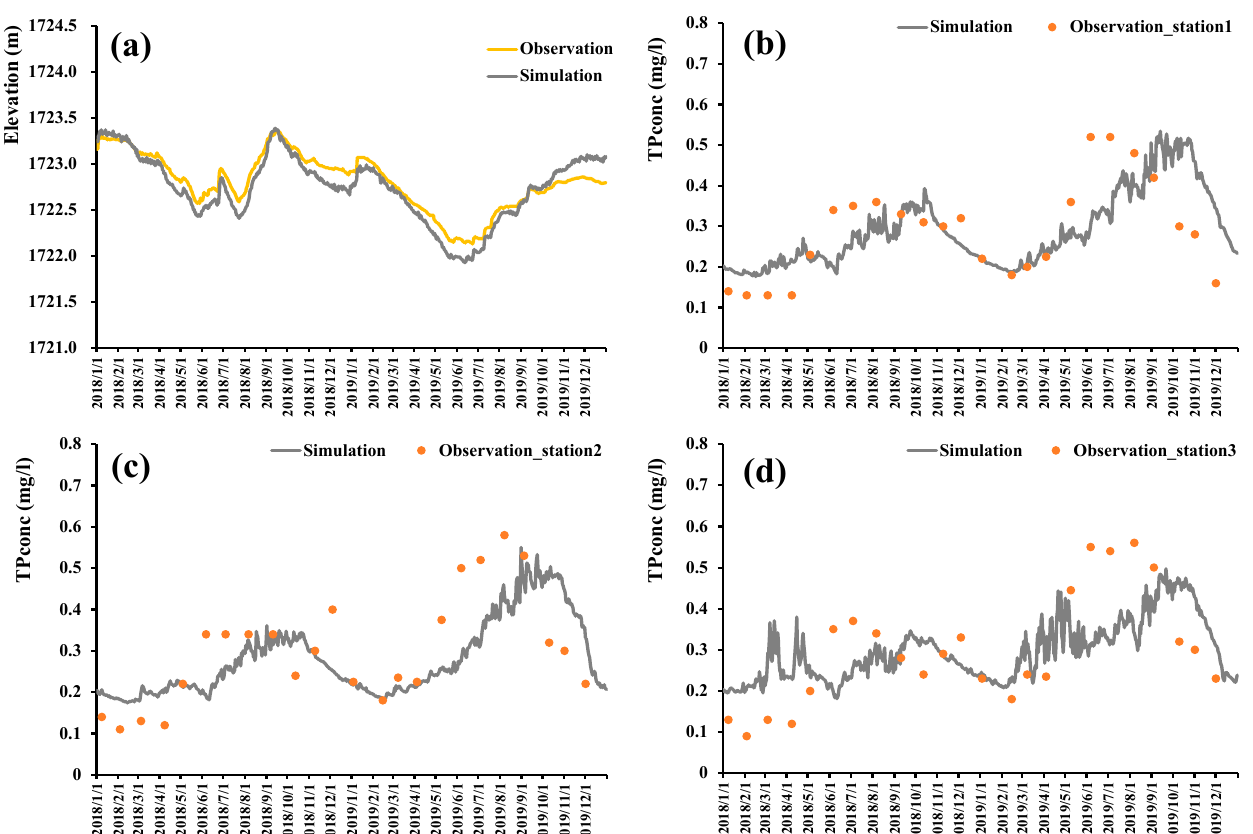
Figure 6. Model validation: simulated water level and water quality vs. observed data at the gauging station and monitoring stations: ( a ) water level validation. ( b–d ) Total phosphorus (TP) concentration validation.